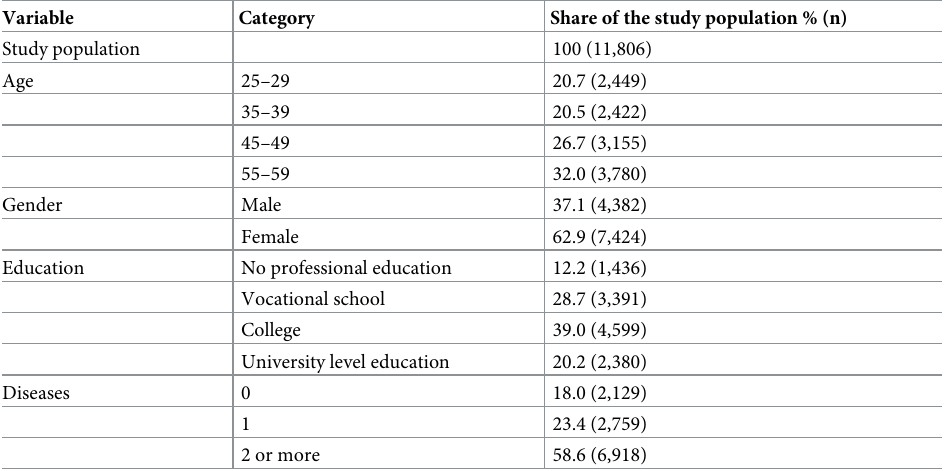
Table 1. Baseline characteristics of the participants in